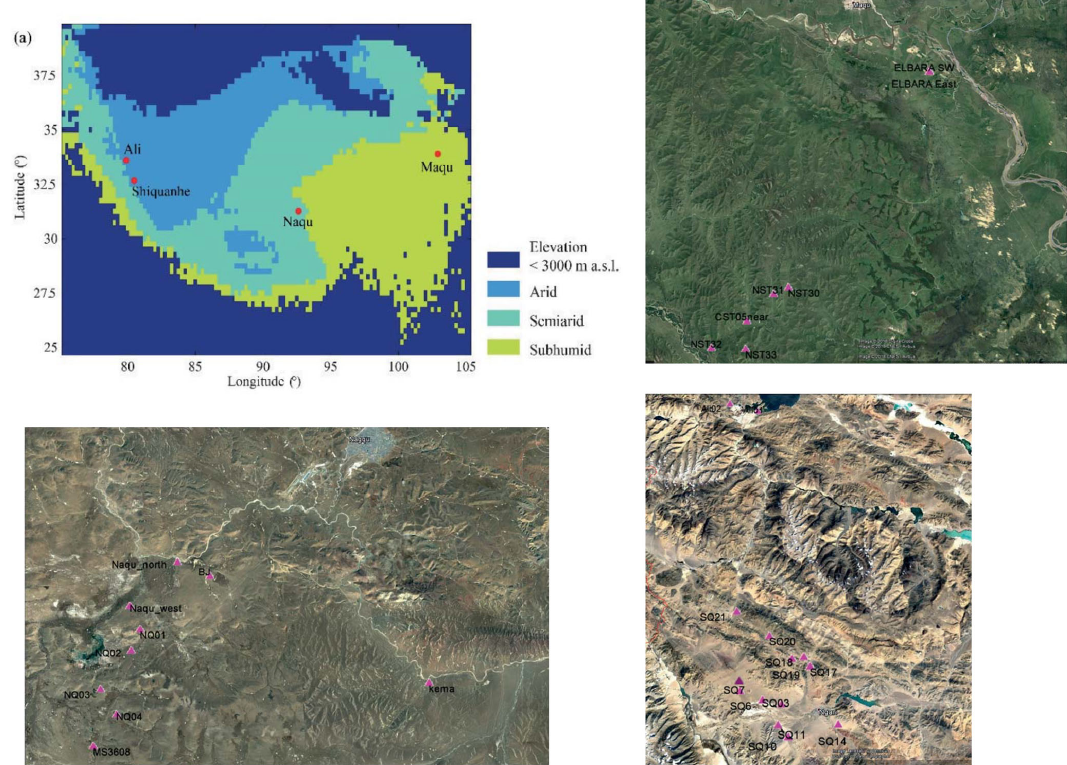
Figure 1. The location of Tibet-Obs and the spatial distribution of soil sampling across three climate zones. (a) Tibet-Obs networks are distributed under the three different climatic zones where the zones were classified based on the FAO aridity index map. The dark blue color represents the area around Tibetan Plateau, with elevation lower than 3000m above sea level (a.s.l.) (Zeng et al., 2016). (b) , (c) and (d) are sampling distributions in the Maqu network under the subhumid zone, Naqu network under the semi-arid zone and Ngari network under the arid zone, respectively, in the KML image from Google Earth. It should be noted that the image acquisition times were in August, February and December, respectively. The triangle in ginger pink represents each sampling